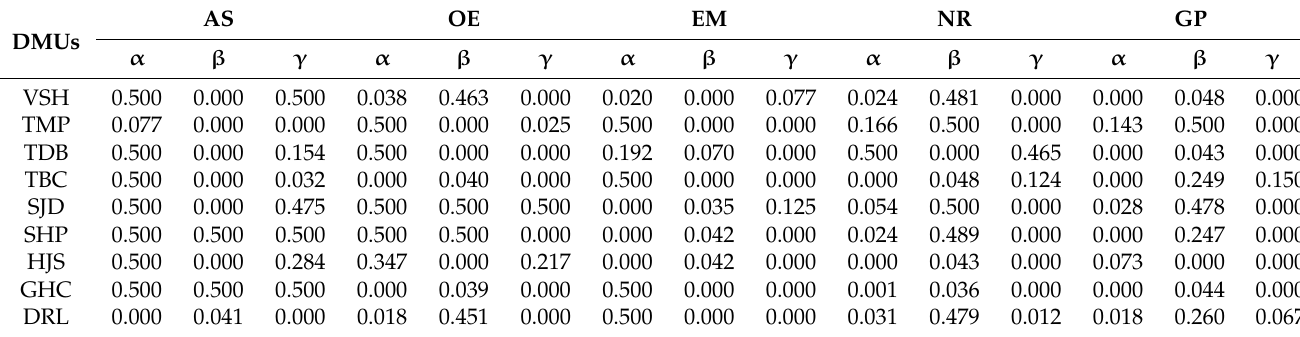
Table 3. Parameter space of inputs and outputs.